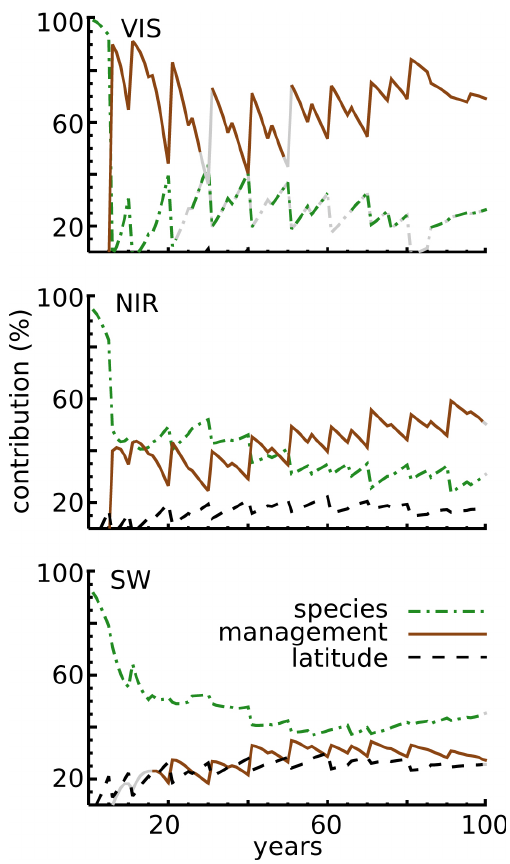
Fig. 4. Contribution (%) of the factors species, management and latitude to the total variance of albedo (June) in visible (VIS), near- infrared (NIR) and the shortwave (SW) wavelength bands. Only contributions larger than 10% are shown. The grey line segments indicate non-significant contributions ( p > 0 . 01). Contributions of the interaction terms do not exceed